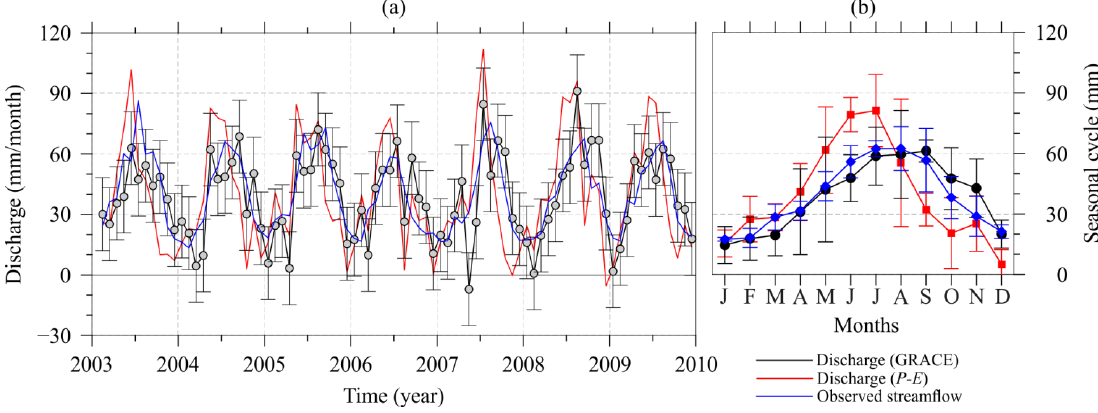
the standard deviation for the monthly mean